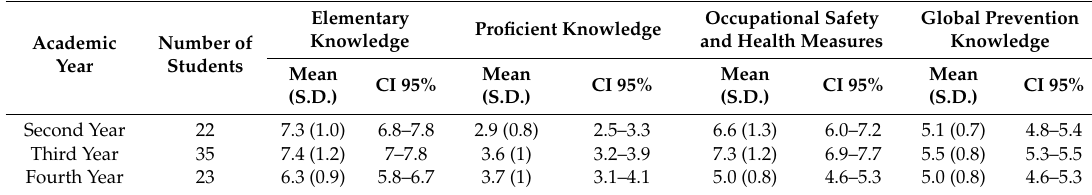
Table 2. Descriptive analysis of each year of the 80 students.